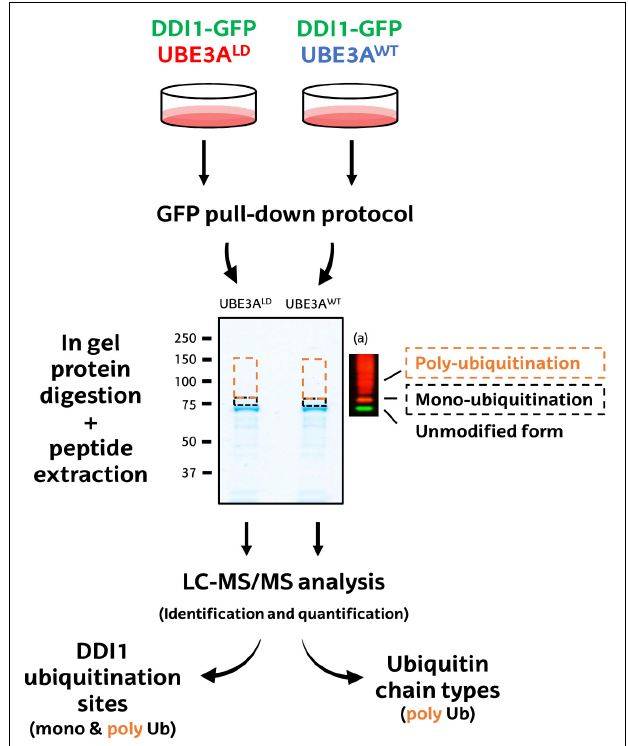
FIGURE 2 | Schematic diagram of the MS-based procedure used to study ubiquitination sites and ubiquitin chain types on DDI1. HEK293T cells were co-transfected with DDI1-GFP and wild type UBE3A (UBE3A WT ) or ligase dead UBE3A (UBE3A LD ). Unmodified DDI1-GFP as well as its ubiquitinated forms were isolated by GFP pull-down, and separated by SDS–PAGE. The gel slice corresponding to ubiquitinated DDI1-GFP was excised and divided into two, basing on a previous western blot (a); a lower band corresponding for mono-ubiquitinated DDI1-GFP (black), and a band above it corresponding to poly-ubiquitinated DDI1-GFP (orange). Gel slices were digested with trypsin, and resulting peptides were extracted from the gel to further identify and quantify them by LC-MS/MS. Both bands were analyzed to infer DDI1 ubiquitination sites, whereas only the poly-ubiquitination band was used to detect the nature of the ubiquitin chain types formed on